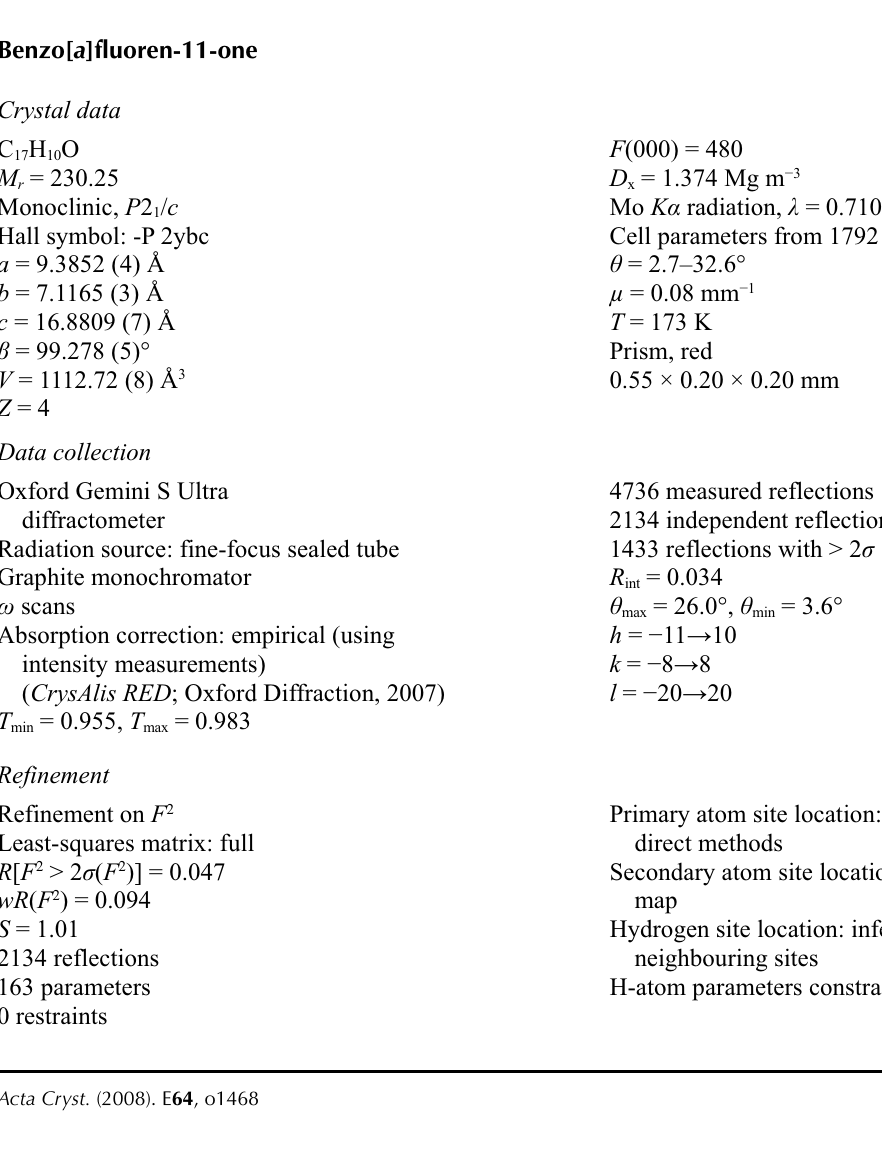
Figure 1 ORTEP Molecular view of compound I. Thermal ellipsoids are drawn at the 50% probability level. H atoms are represented as small spheres of arbitrary